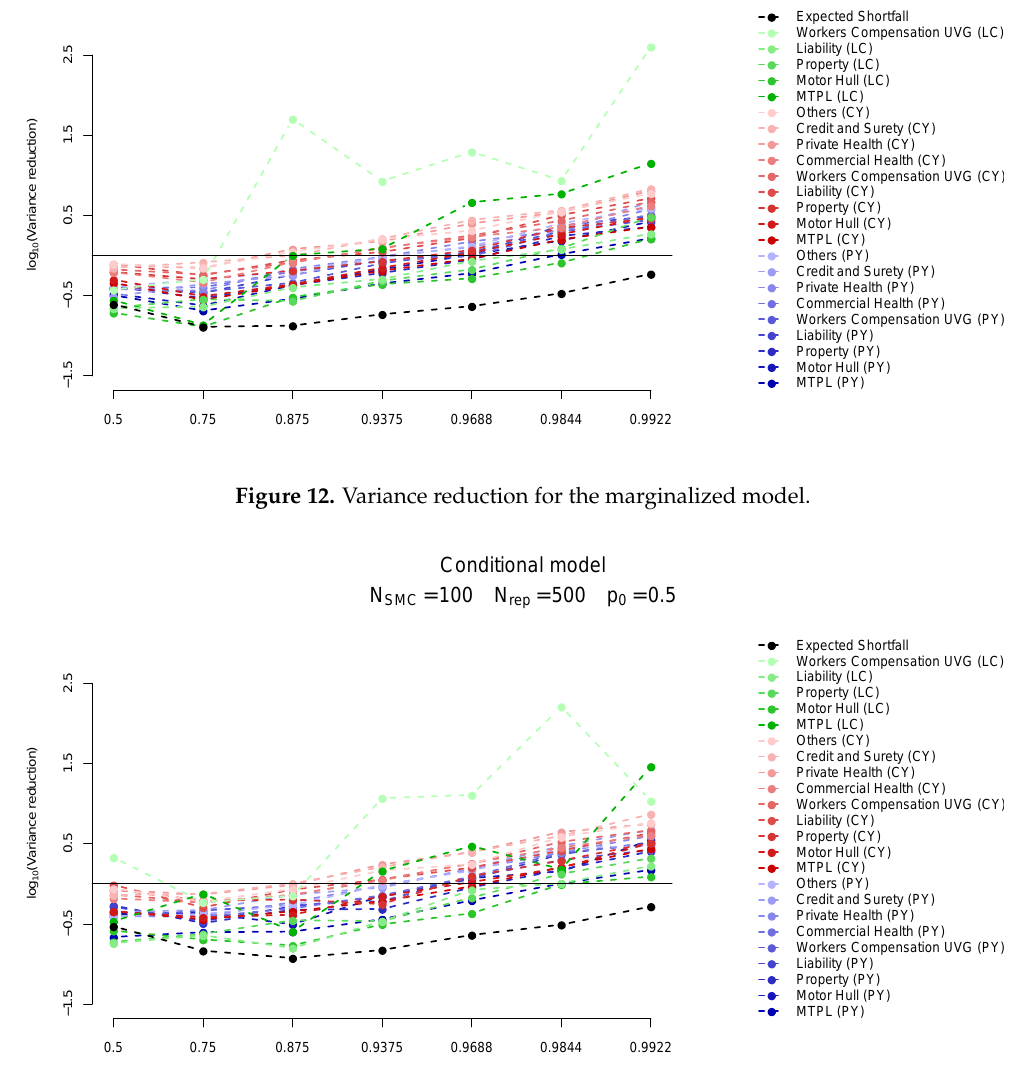
Figure 13. Variance reduction for the conditional